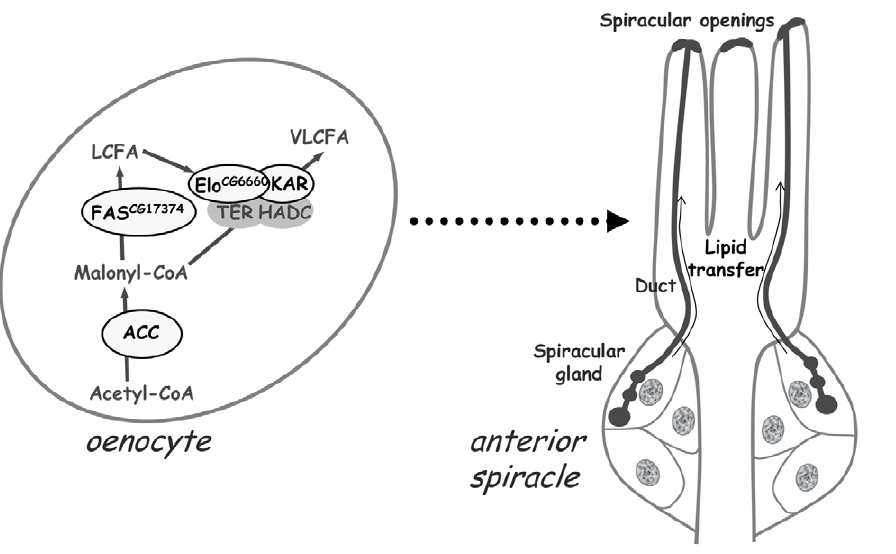
Figure 7. A VLCFA–dependent remote signal from the oenocytes controls lipid transfer within the spiracles. The default of VLCFA synthesis within the oenocytes provokes the failure to transfer lipids through the spiracular ducts from the spiracular gland to the spiracular opening. The gene products identified to be involved in this metabolic pathway within the oenocytes are indicated (oval forms surrounded in black). The signal running from the oenocytes to the spiracles is yet unidentified.